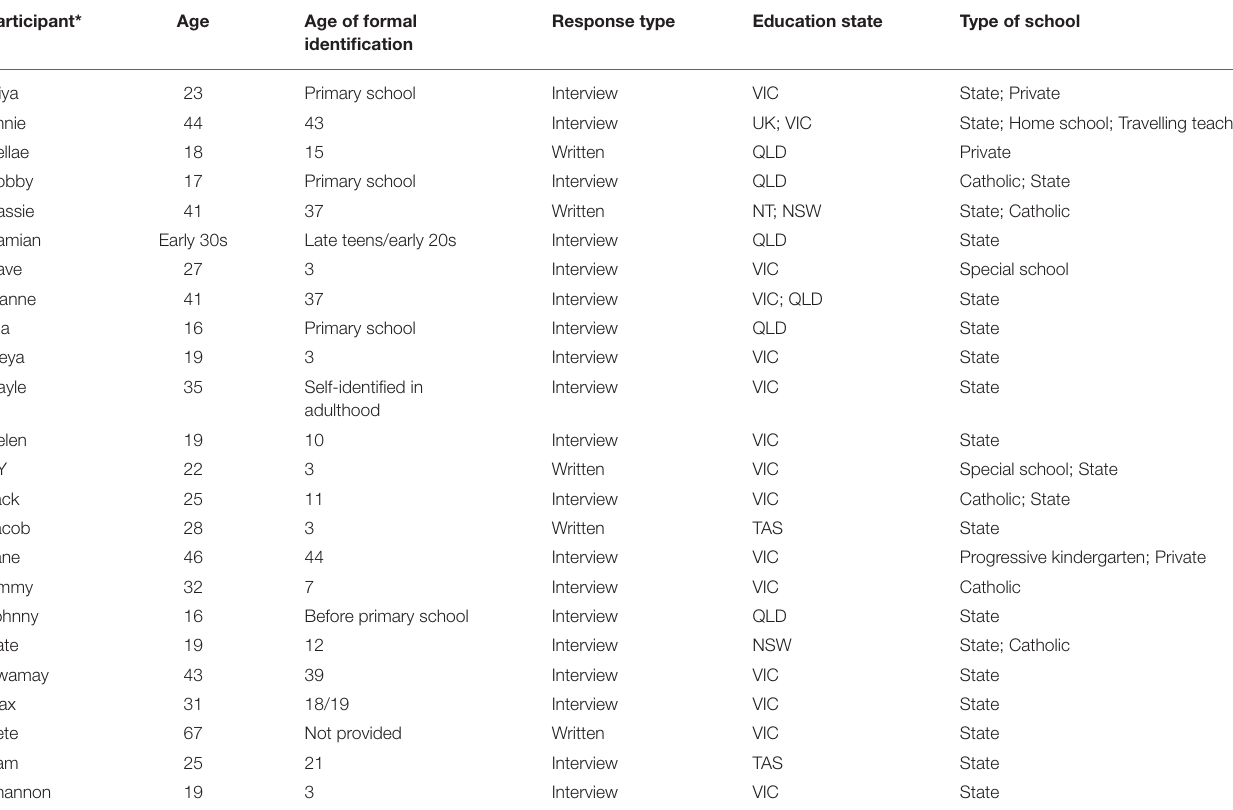
TABLE 1 | Summary of